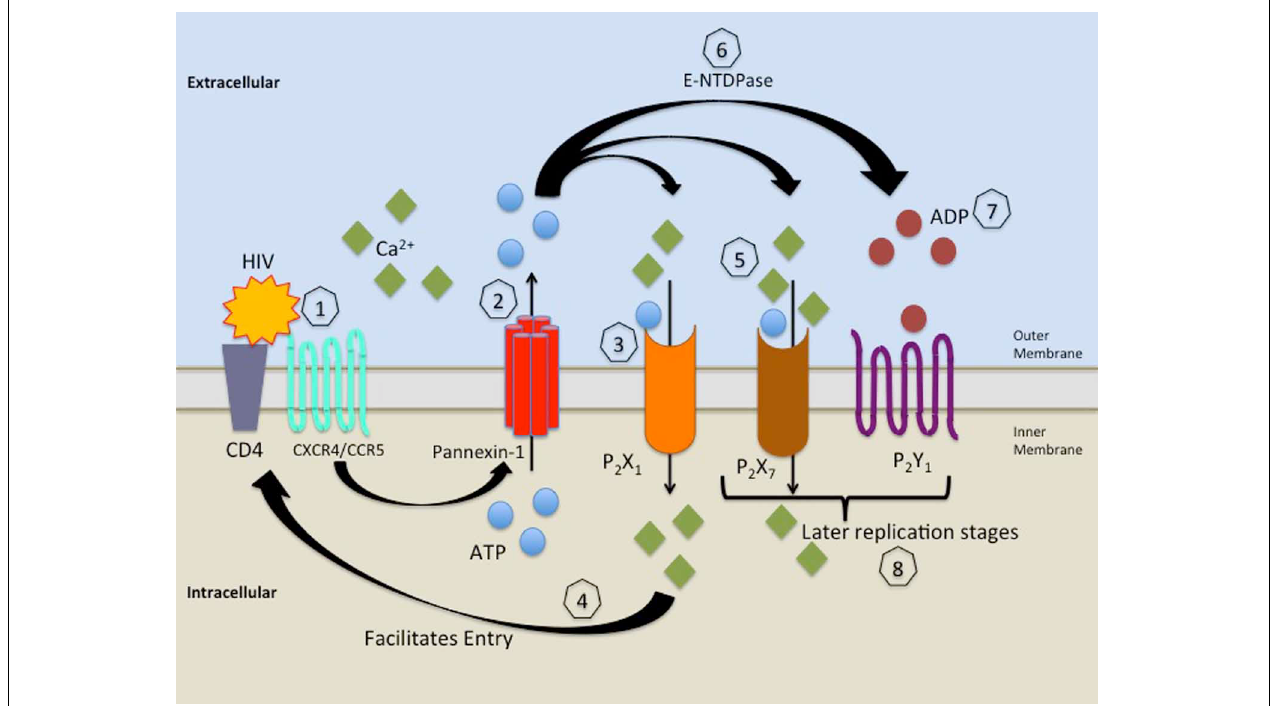
FIGURE 2 | Proposed model for the role of Panx-1 hemichannels and purinergic receptors in HIV infection. HIV’s binding to CD4 and CXCR4/CCR5 (1) induces signaling which leads to opening of Panx-1 hemichannels and release of ATP (2). Extracellular ATP released through open Panx-1 hemichannels binds to and activates P2X1 receptors causing calcium influx (3), which facilitates HIV entry (4). The release of